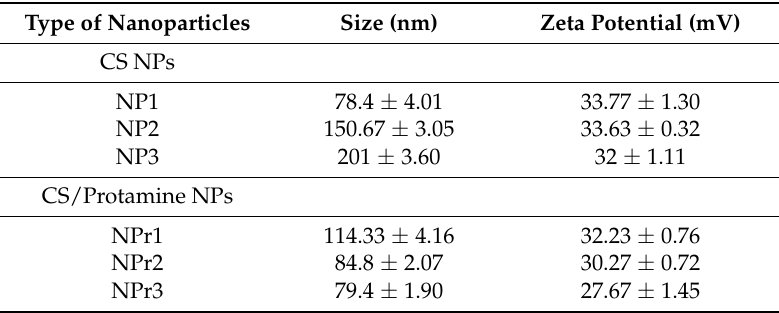
Table 2. Size distribution and zeta potential of chitosan (CS) nanoparticles